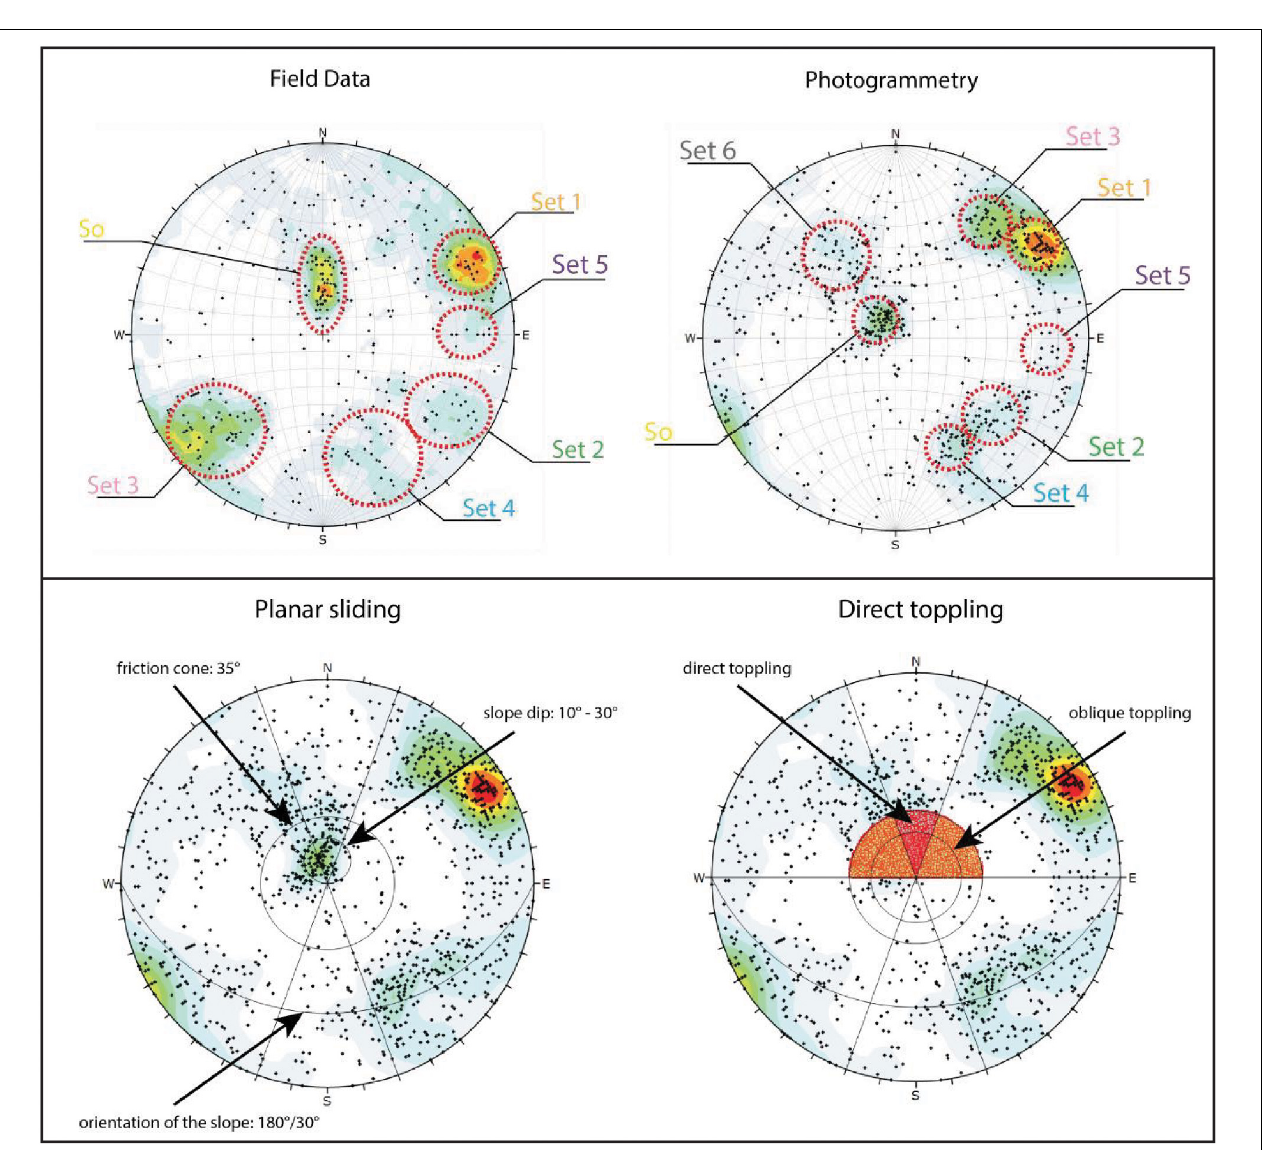
FIGURE 6 | Top: discontinuity measurements taken from the field and from photogrammetry. Bottom: Results of the kinematic analysis.